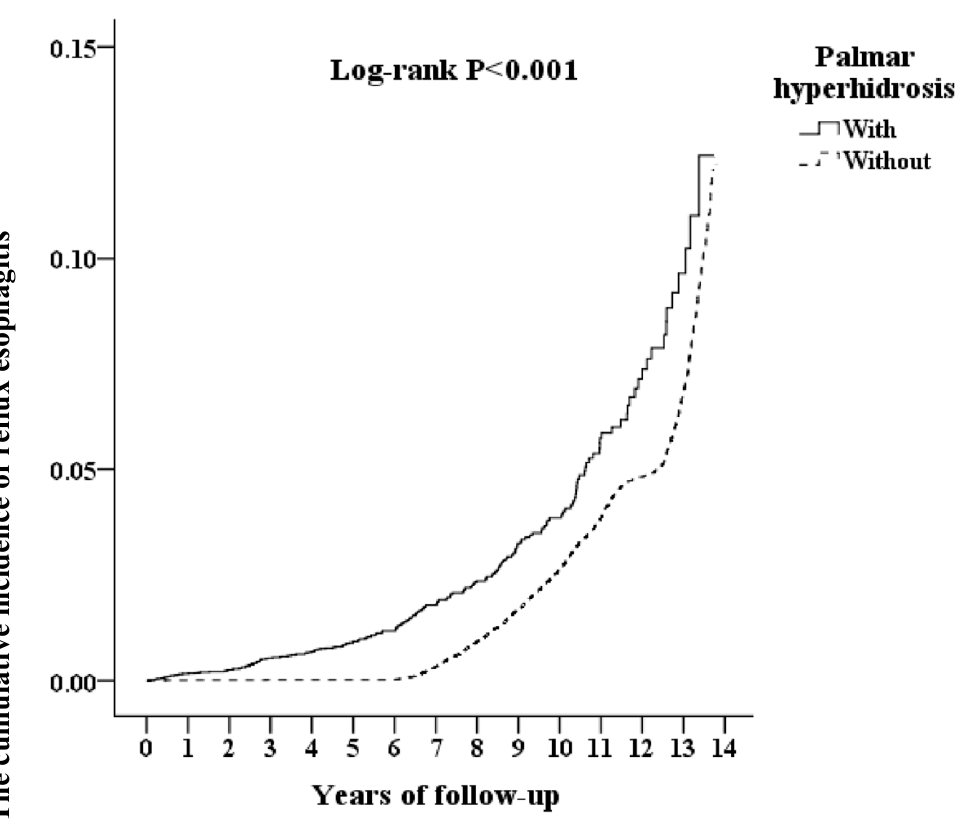
Figure 2. The cumulative incidence of reflux esophagitis by a Kaplan–Meier curve with log-rank test.